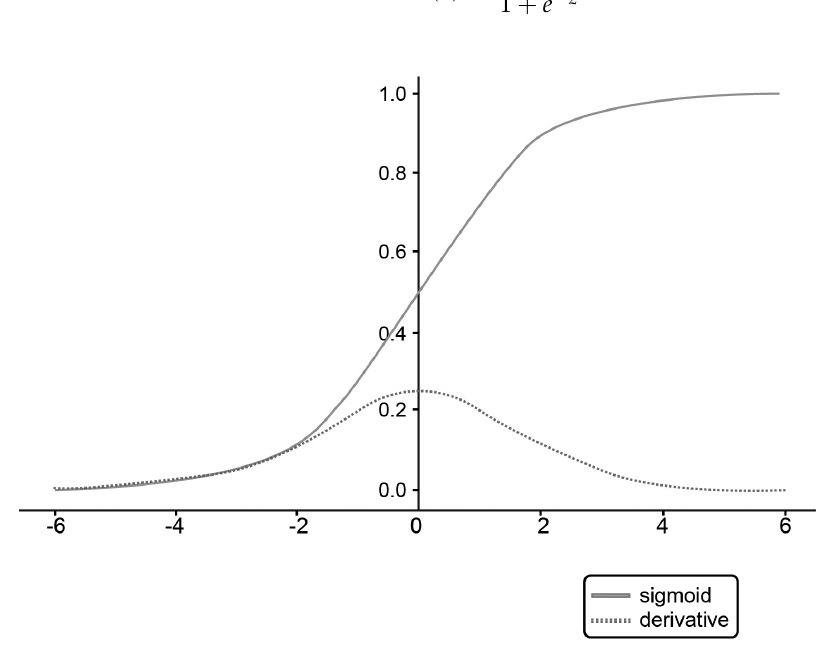
Figure 3. Sigmoid and its derivative